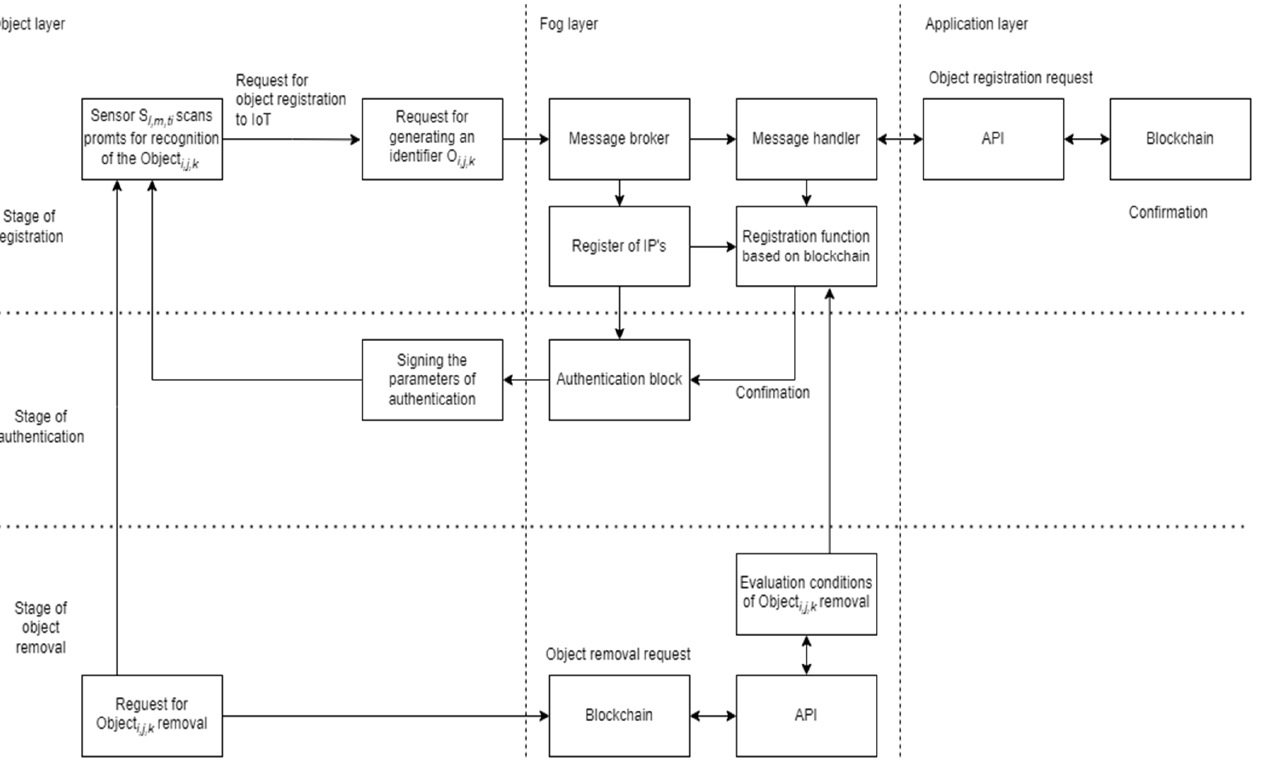
Figure 3. Integration of stages for registration, authentication, and removal of moving transport objects in the system based on the IoT technological platform.